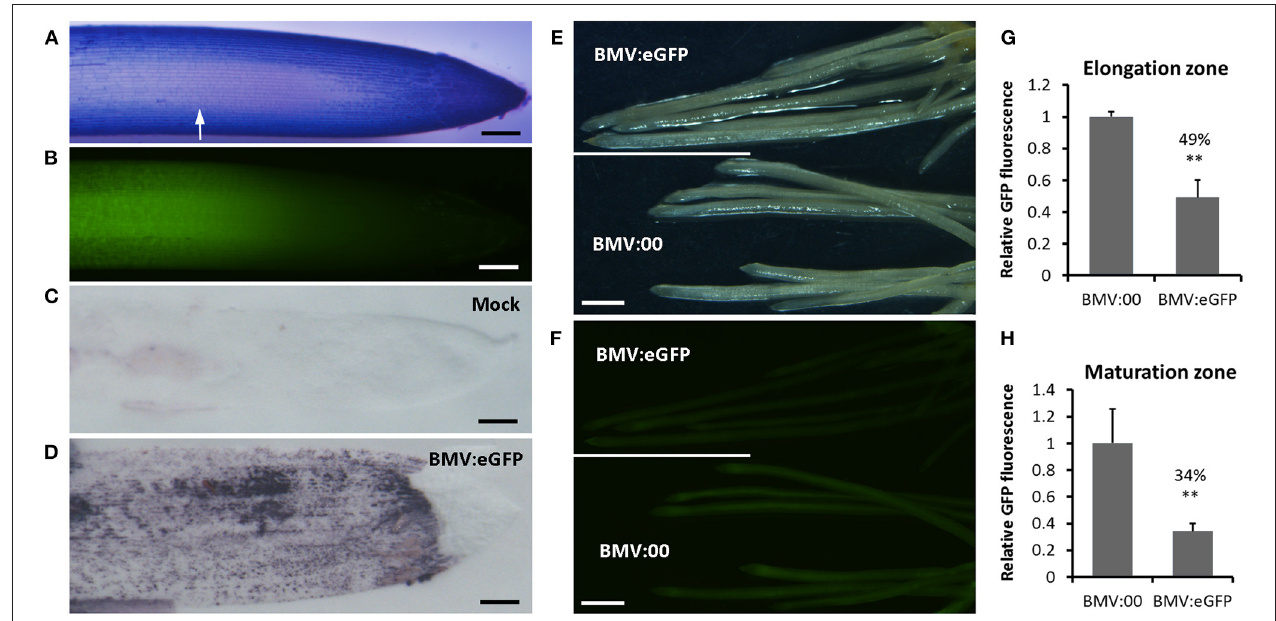
FIGURE 4 | Silencing transgenically-expressed GFP in wheat roots with BMVCP5. (A) Root apical region from transgenic OsRCg2GFP wheat ( cv . fielder) seedlings expressing GFP stained with toluidine blue. White arrow indicates the start of the elongation zone. (B) Green fluorescence from GFP detected in the elongation zone of the same root as in panel (A) . Accumulation of BMV in a wheat root from plants inoculated with sap of N. benthamiana leaves without virus ( Mock, C) , or containing BMV:eGFP (180-nt insert; D ), detected by tissue-print assay using a polyclonal antibody against the BMV CP. Purple color indicates presence of virus. Bars in (A–D) = 200 µ m. (E) Bright-field image of roots at 21 dpi from plants infected with BMV:eGFP or BMV:00 (no insert control). (F) Fluorescence from roots in panel E showing silencing of GFP in transgenic OsRCg2GFP wheat roots after infection with BMV:eGFP, but not BMV:00. Images taken with an Olympus SZX 12 fluorescence microscope. Bars (E,F) = 1mm. Similar results were obtained in three independent experiments. Quantification of GFP fluorescence in the elongation zone (G) and maturation zone (H) of roots at 21 dpi from plants infected with BMV:00 or BMV:eGFP. Values represent means + SD of six to eight biological replicates,